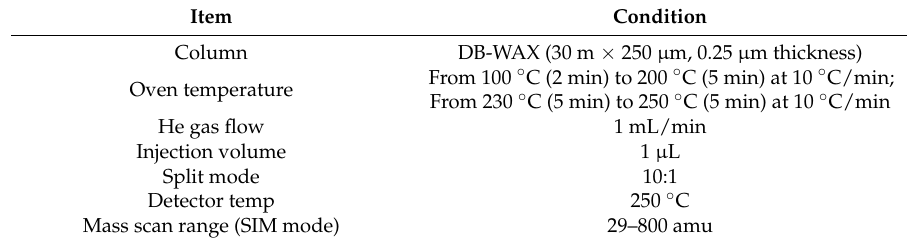
Table 2. Operation conditions of gas chromatography mass spectrometry (GC-MS) analysis used in this work.